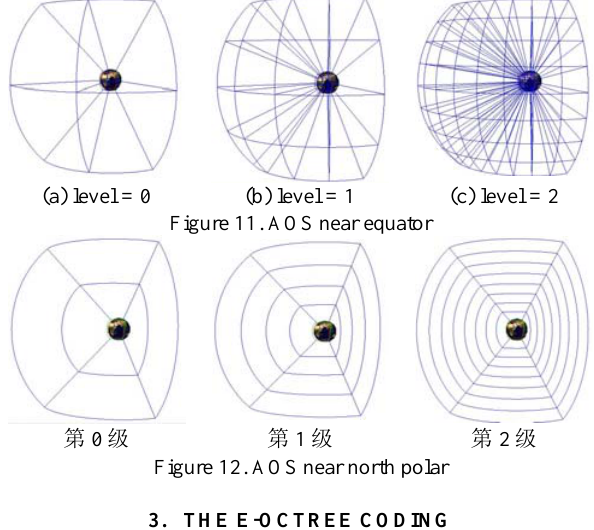
Figure 12. AOS near north polar